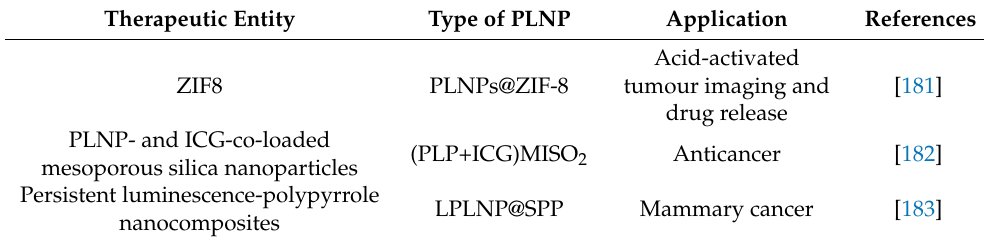
Table 12. Types of PLNPs with their applications in cancer therapy.